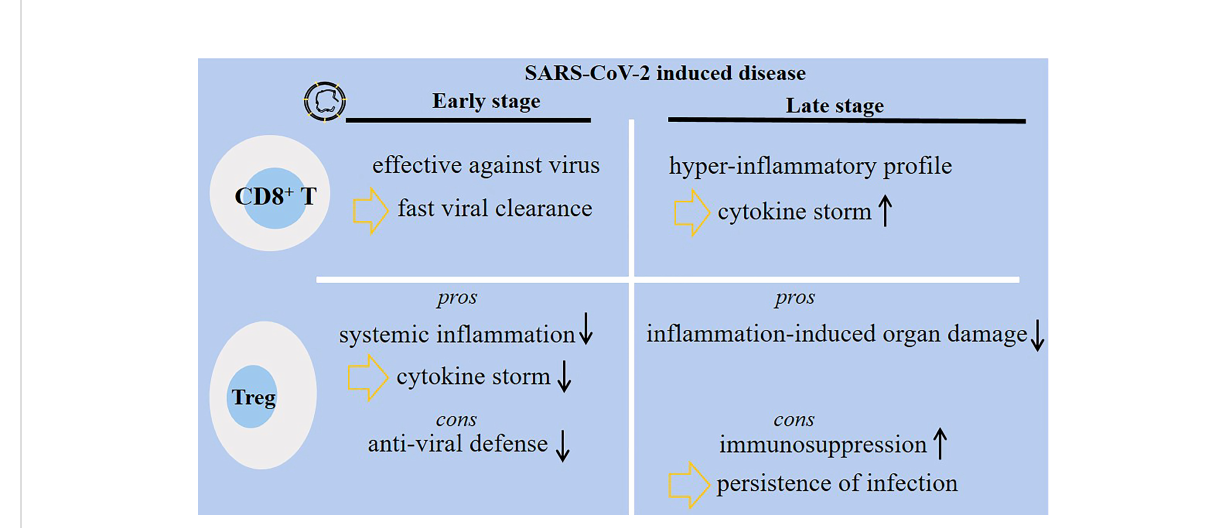
FIGURE 3 Diverse functionality of CD8 + T cells and regulatory T cells (Tregs) in patients with SARS-CoV-2-induced disease. During the early-stage of the disease, the activity of CD8 + T cells is protective, whereas the cells are hyper-active and amplify in fl ammatory responses associated with cytokine storm and lung damage at late stage of the disease. Tregs have their own pros and cons during each disease stage. At early stage, Tregs dampen systemic in fl ammation, but they can hamper anti-viral defense systems. At late stage of the disease, Tregs protect body organs from in fl ammatory-related damages, but they may promote immunosuppression and further persistence and delayed clearance of the